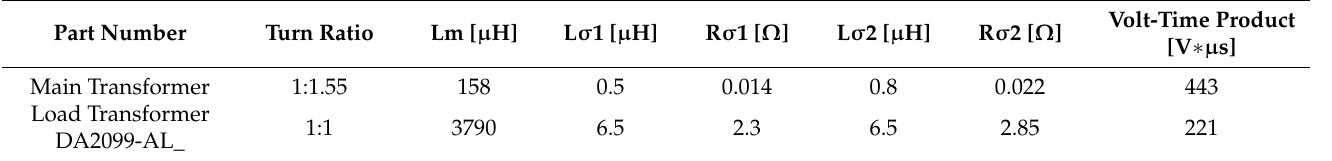
Table A1. Transformers